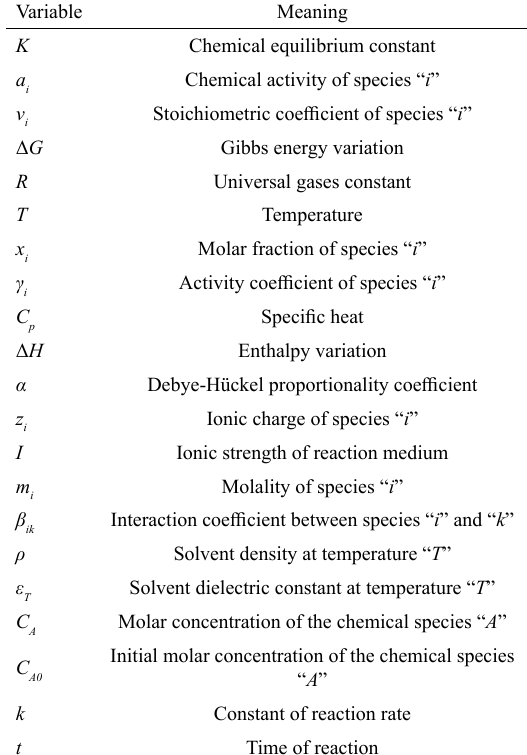
Table 1. Nomenclature